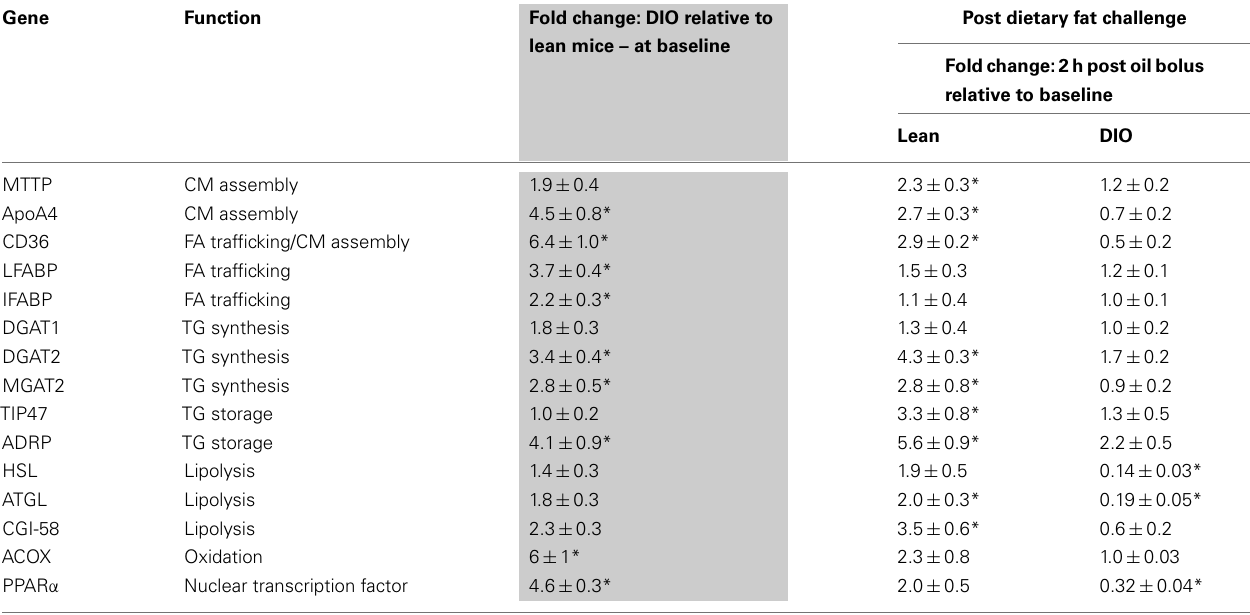
Table 4 | Relative mRNA levels for genes involved in regulation of intestinalTG metabolism. Gene Function Fold change: DIO relative to